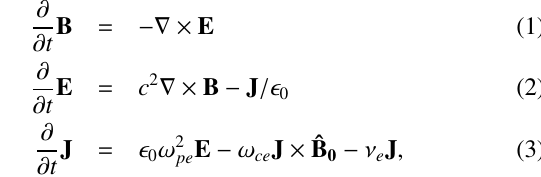
Table 1. Simulation parameters for the benchmark together with typical ASDEX-Upgrade values